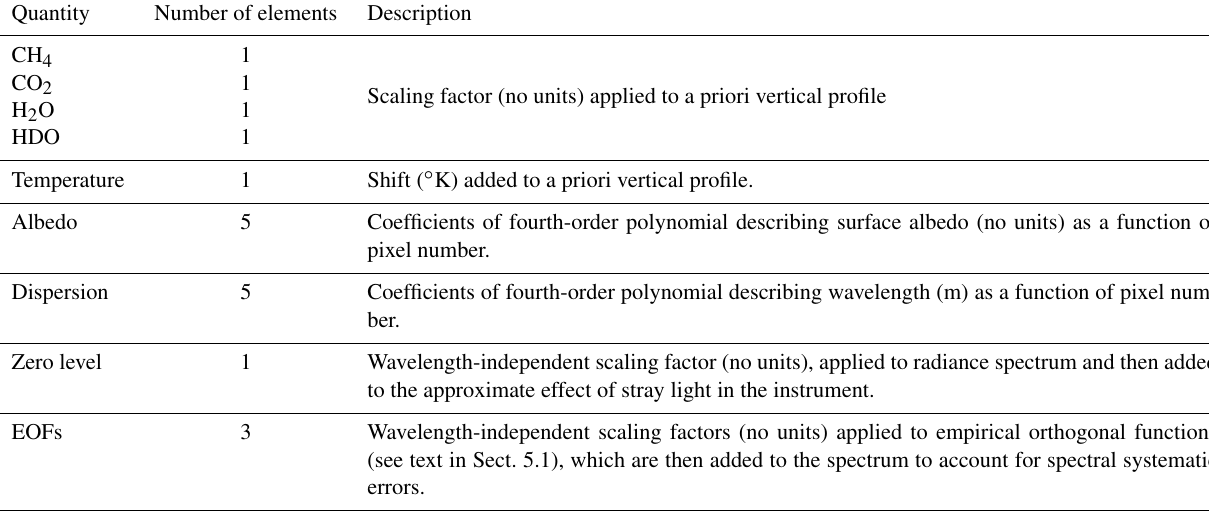
Table 8. Description of the state vector.